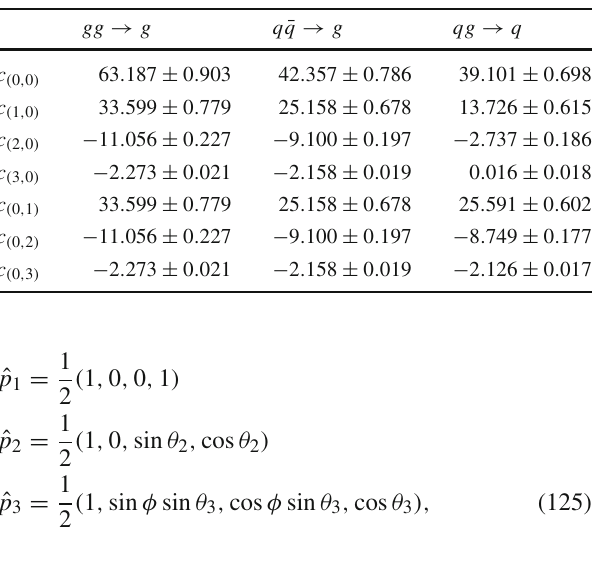
Fig. 5 Numerical results and fitted form for the coefficient of δ( T 1 ) in the three partonic configurations as a function of y 13 ∈ [ 0 , 1 ] . Included in the plot are the fitting uncertainties at the 95% confidence level Table 2 Non-zero coefficients of the numerical fit of Eq. (123) for the three partonic configurations gg → g , q ¯ q → g , and qg → q . Coefficients not shown here are understood to be